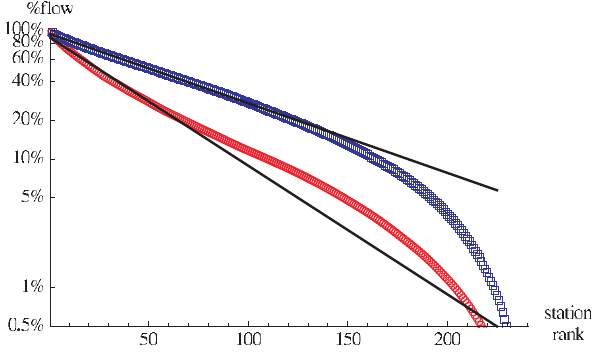
Figure 3. Total flow distributions. Zipf plot for the total inflows ( red circles , below ) and total outflows ( blue squares , above ) for morning peak hours (7am–10am). The inflow I (outflow O ) of a station j ( i ) is defined w ij ( O ( i ) ~ P w ij ). The straight lines are exponential fits of as I ( j ) ~ P i j ^ 2 : 27 : 10 { 2 for the inflow and the form e { r = r 0 with 1 = r in 0 ^ 1 : 40 : 10 { 2 for the outflow. 1 = r out 0